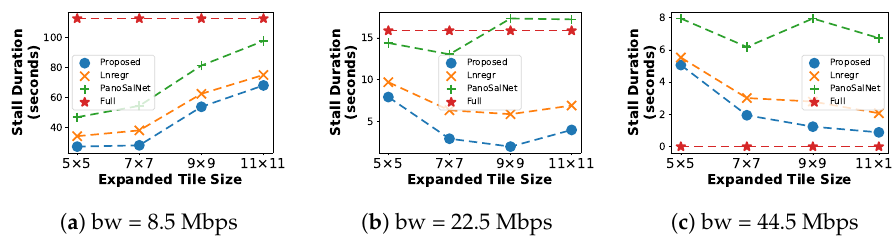
Figure 5. Buffer Stall Duration under different bandwidth conditions.